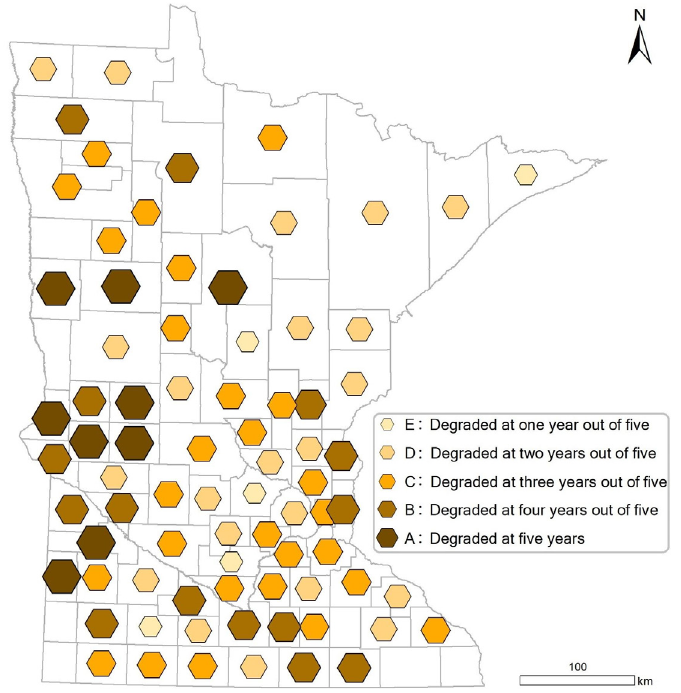
Figure 16. The spatial distribution of degradation zones.